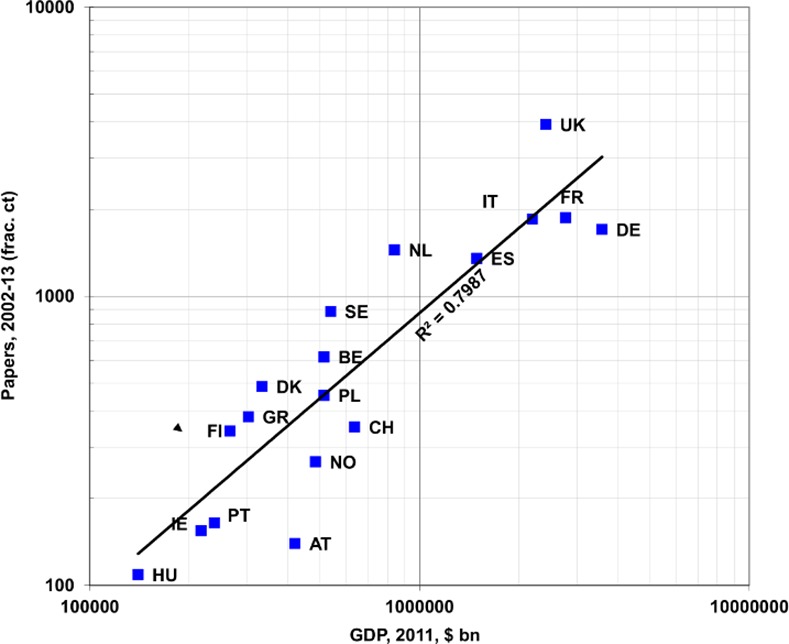
Plot of RESPI paper output, 2002–13, against GDP for 18 European countries with fractional counts above 100 papers.Note: BG, CY, CZ, EE, HR, IS, LT, LU, LV, MT, RO, SI and SK omitted. For codes, see Table 1.